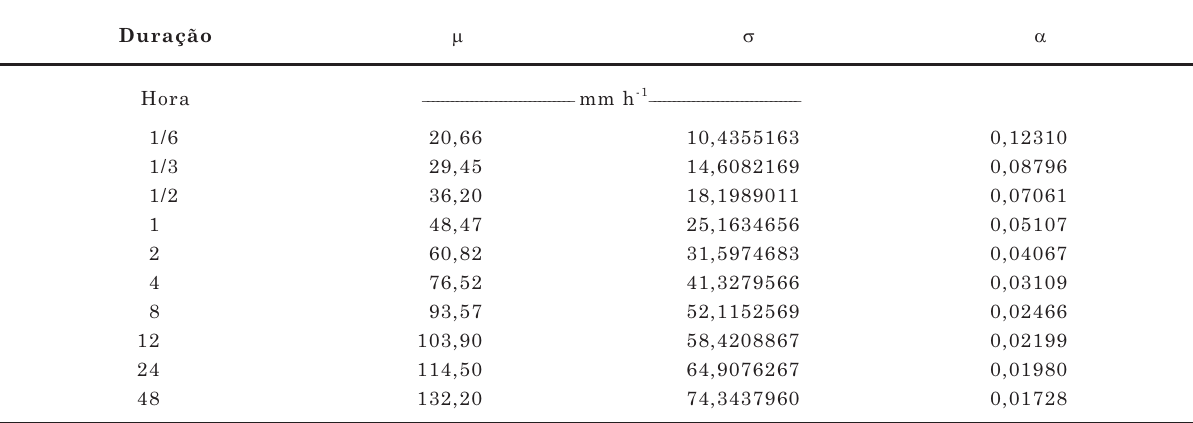
Quadro 6. Valores da intensidade média ( μ ), desvio-padrão ( σσσσσ ) e parâmetro ααααα para diferentes durações da chuva em